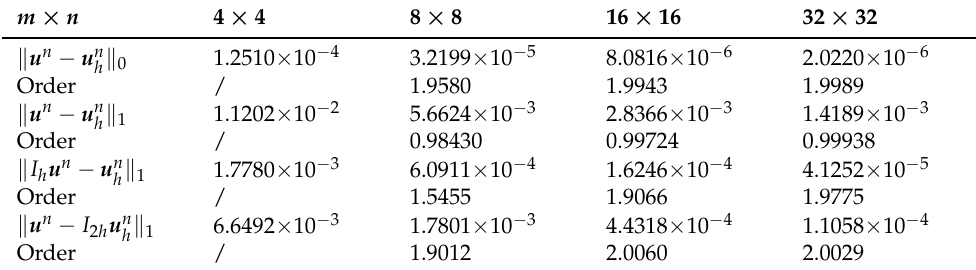
Table 5. The numerical errors and convergence orders at t = 1.0 of u .